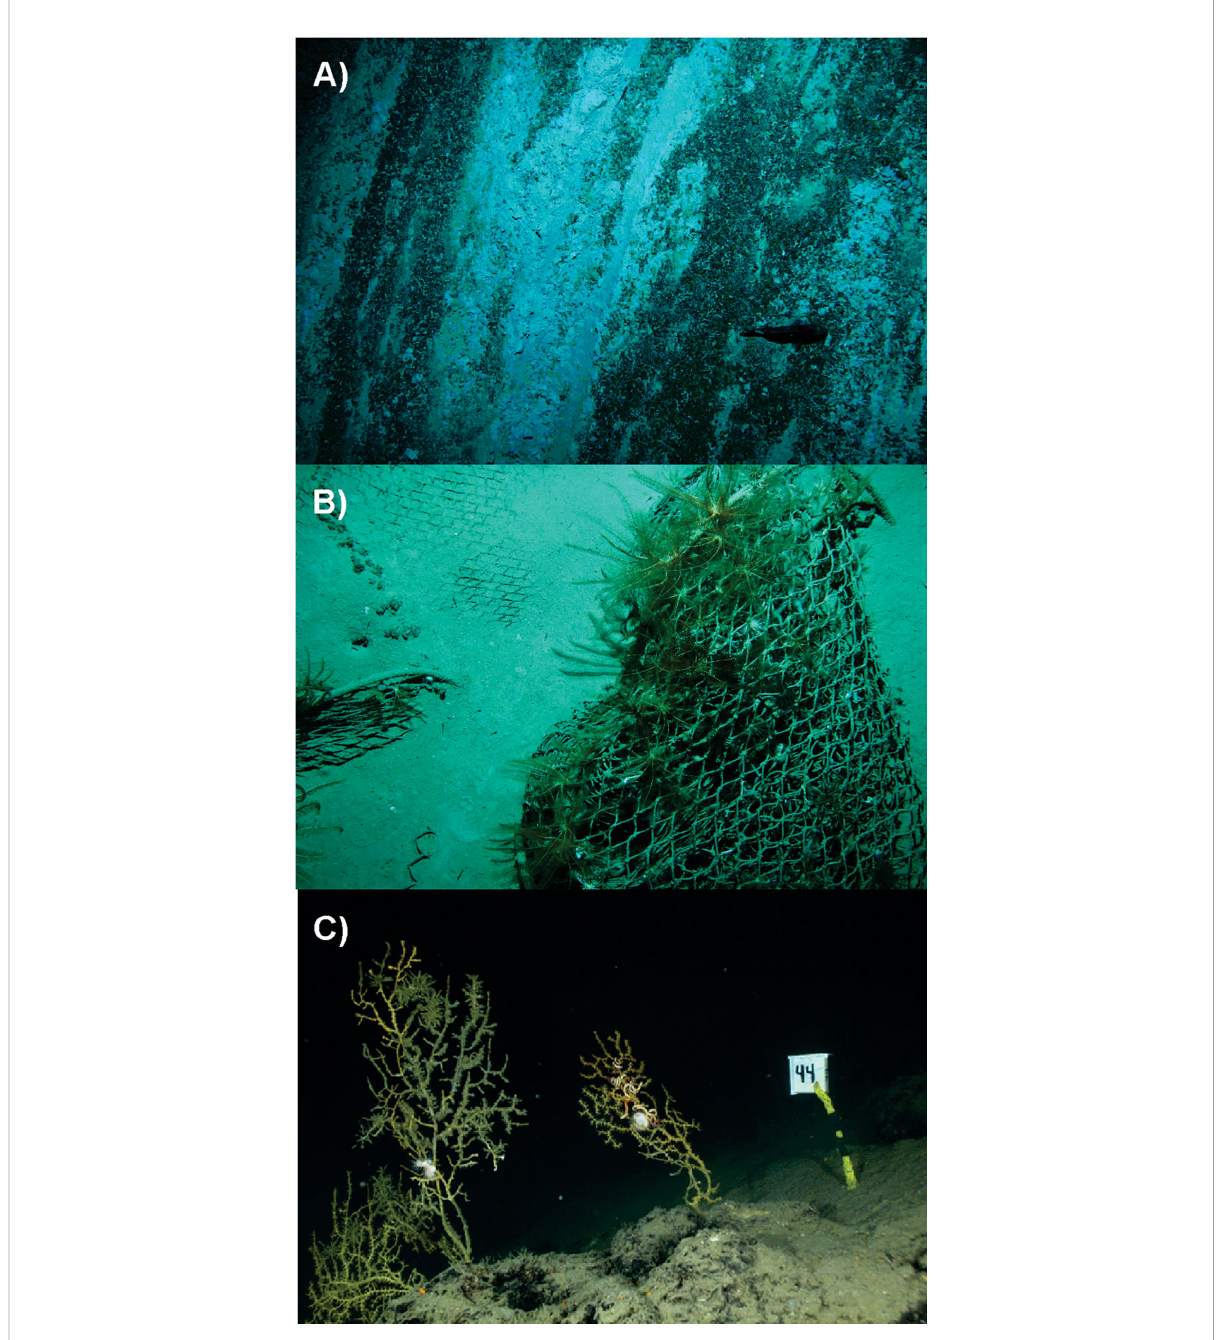
FIGURE 3 Destruction of benthic habitats derived from the activities of deep-sea fi sheries and oil and gas. (A) trawled zone of the seabed. Photo courtesy of Malcom Clark. (B) lost net. Photo courtesy of Malcom Clark. (C) Paramuricea biscaya colonies showing varying degrees of impact from oil and the applied dispersants 18 months after the Deepwater Horizon blowout. Photo from the R/V Holiday Chouest expedition, Mississippi Canyon area, October 2011, courtesy of Erik